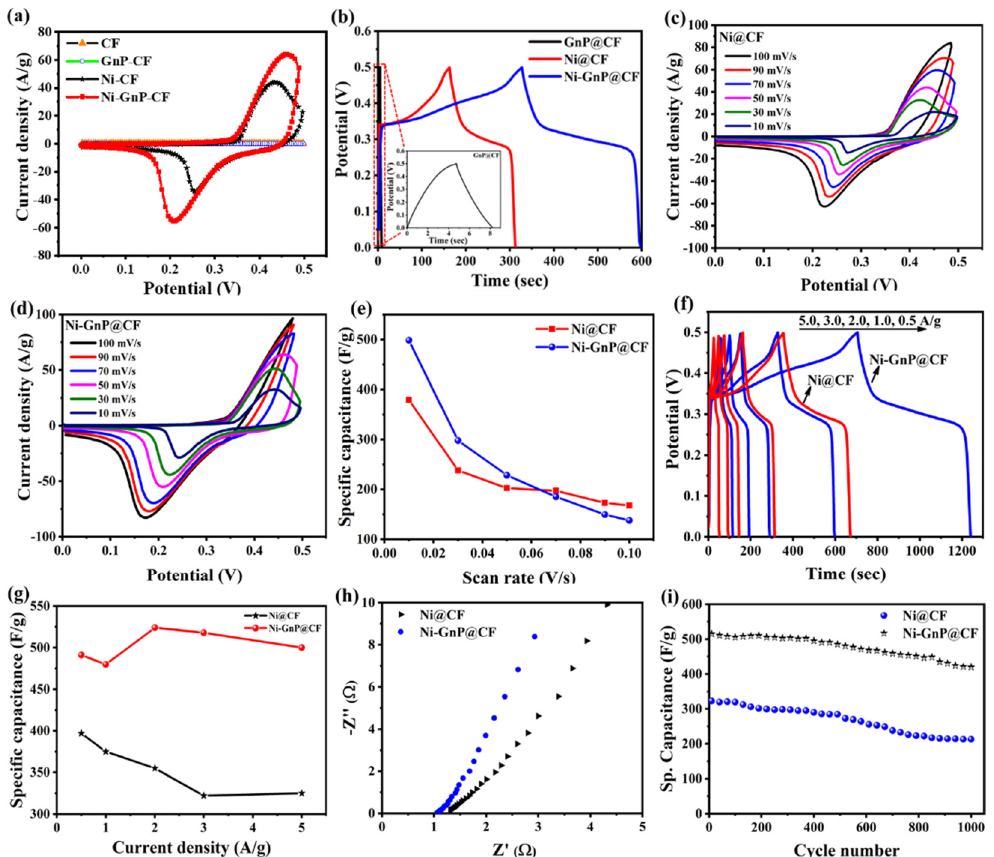
Figure 4. ( a ) Cyclic voltammogram of CF, GnP@CF, Ni@CF, and Ni-GnP@CF at 50 mV/s in 5 M KOH;